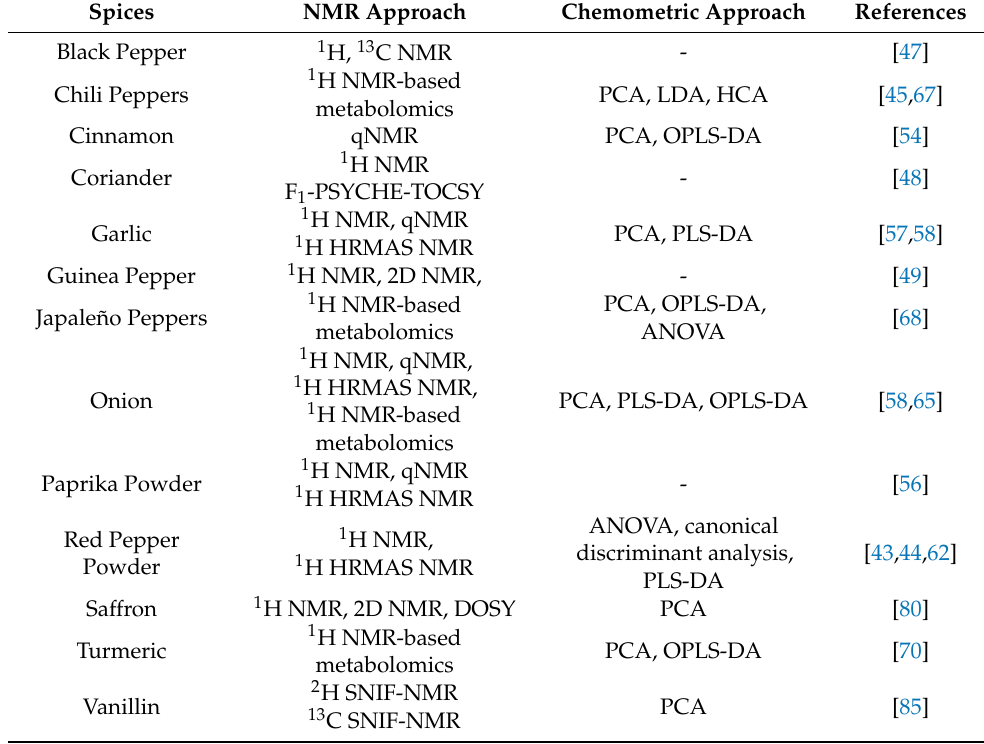
Table 6. A summary overview of NMR approaches used in the adulteration of spices. Spices NMR